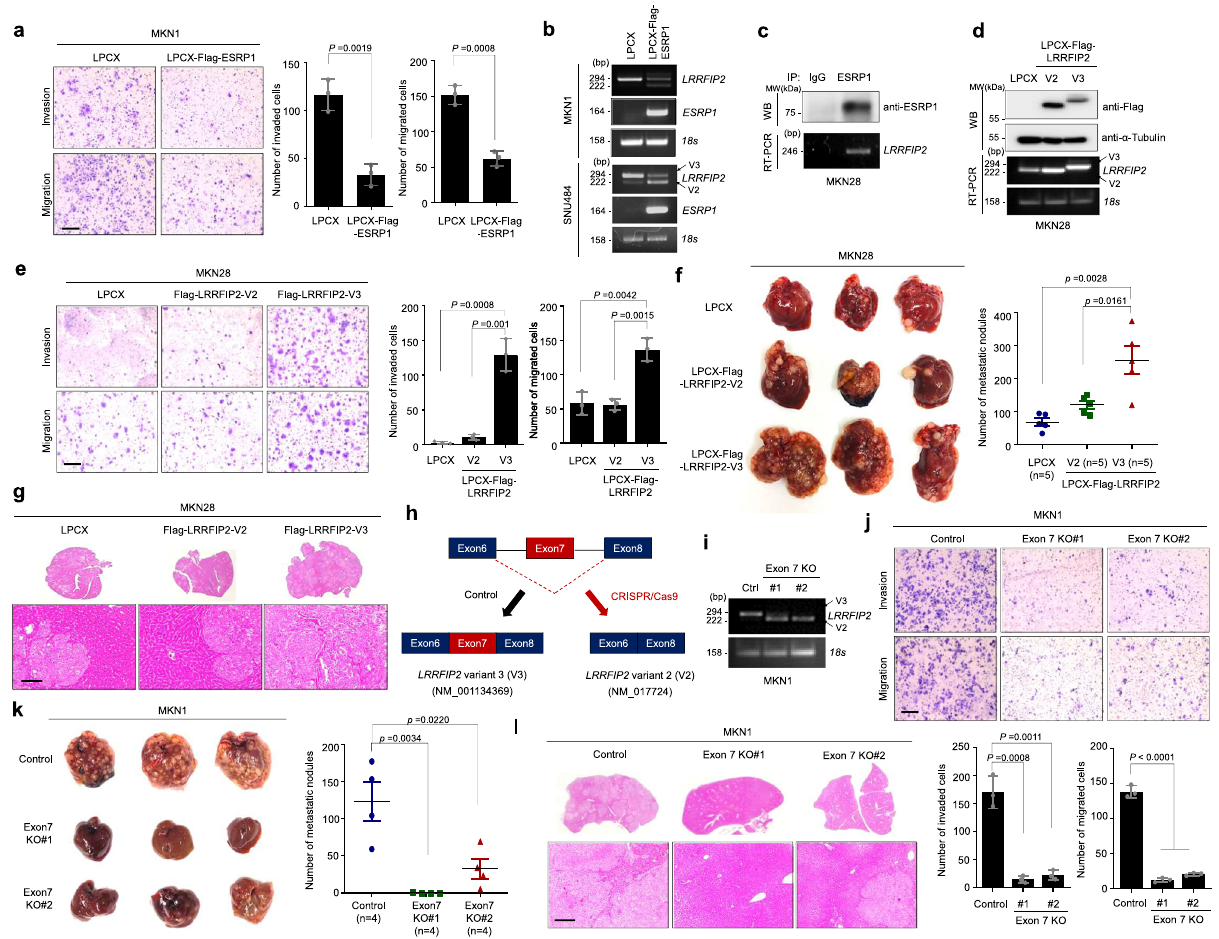
h Schematic representation of exon 7 deletion by CRISPR/Cas9 system. i RT-PCR analysis of LRRFIP2 in exon 7-deleted cell lines. j Transwell migration assay and Matrigel invasion assay of exon 7-deleted cell lines (top) and bar graphs showing number of invaded and migrated cells (bottom), respectively, following staining with crystal violet. Original magni fi cation, _40X. Scale bar, 0.5mm. k Representative whole liver image showing metastatic nodules (left) and scatter plotshowingthenumberoflivermetastaticnodules(right). l H&Estainingshowing sections of the metastasized liver from k . Original magni fi cation, _100X. Scale bar, 100 µ m. a , e , j Dataarerepresentativemean±SDofthreeindependentexperiments ( N =3). b – d, i The representative results were obtained from at least three inde- pendent experiments. f Data are representative mean±SD of fi ve independent animals ( n =5). f Data are representative mean±SD of four independent animals ( n =4). All P values were calculated by unpaired two-tailed Student ’ s t tests. These data represent the mean±S.D. Source data are provided in the Source Data fi